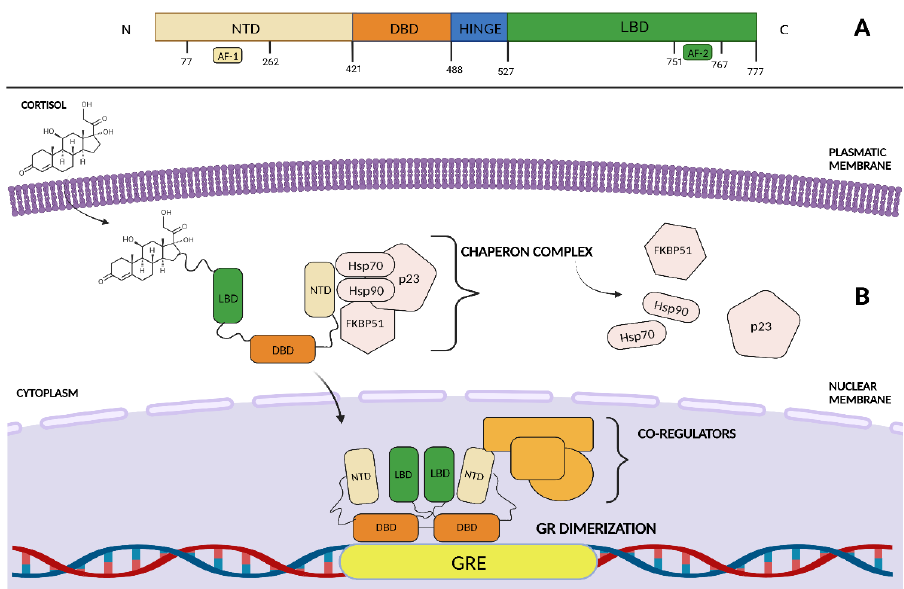
Figure 1. ( A ) The glucocorticoid receptor (GR) linear domain structure. NTD: amino-terminal domain. DBD: DNA-binding domain. LBD: ligand-binding domain. AF-1: activation function domain 1. AF-2: activation function domain 2. ( B ) In the absence of ligand, GR associates with chaperones in